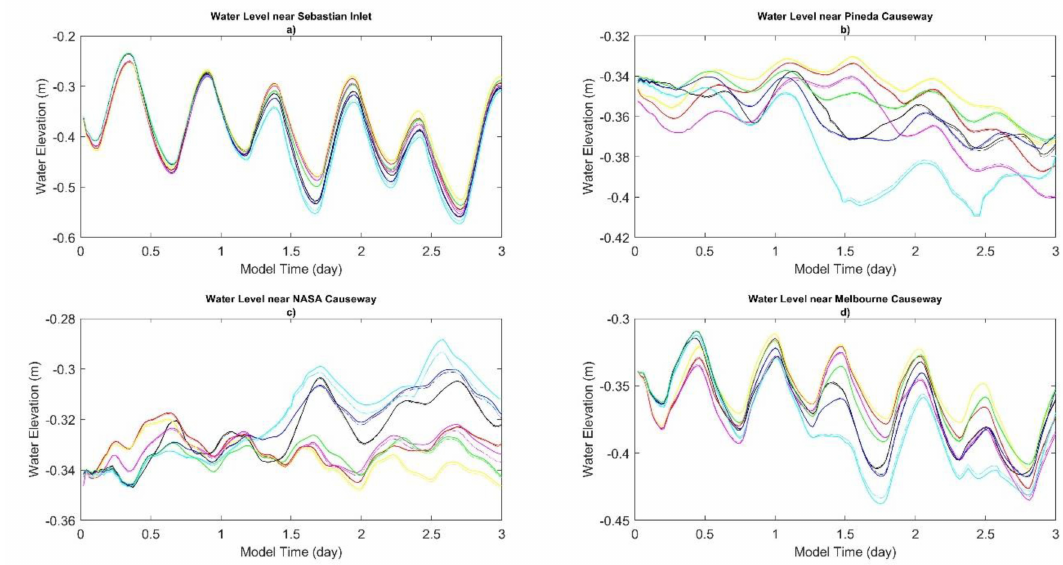
Figure A2. Time series plots of individual ADCparam and ADCIRC + SWAN ensemble members for water elevation (meters) with geoid offset near ( a ) Sebastian Inlet, ( b ) Pineda Causeway, ( c ) NASA Causeway, and ( d ) Melbourne Causeway. The legend is shown in Figure A1. Each of these locations is selected based on location in the domain and associated fetches (station locations are specified in Figure 8).